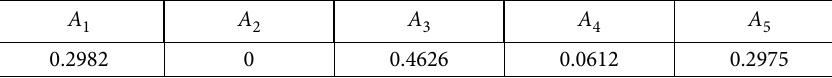
Table 11. The appraisal scores of the enhancement EDAS method based on the PT 1